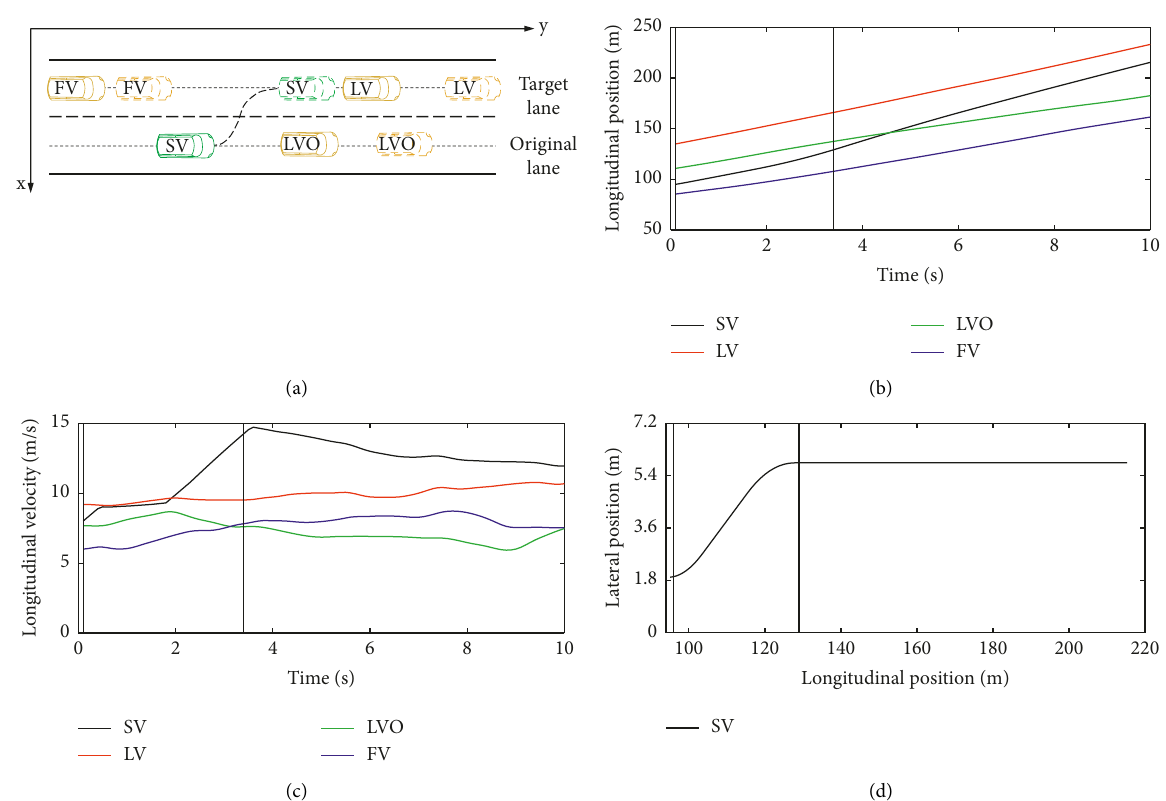
Figure 13: #3 sampled lane-changing scenario. (a) Initial and final state. (b) Plot of longitudinal position with respect to time. (c) Plot of longitudinal velocity with respect to time. (d) Lane-changing